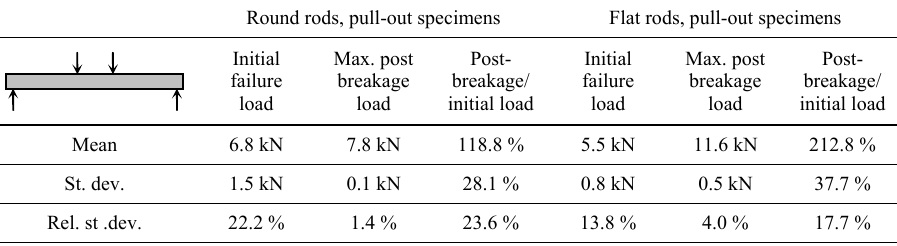
Table 5: Numerical results of the beam tests.